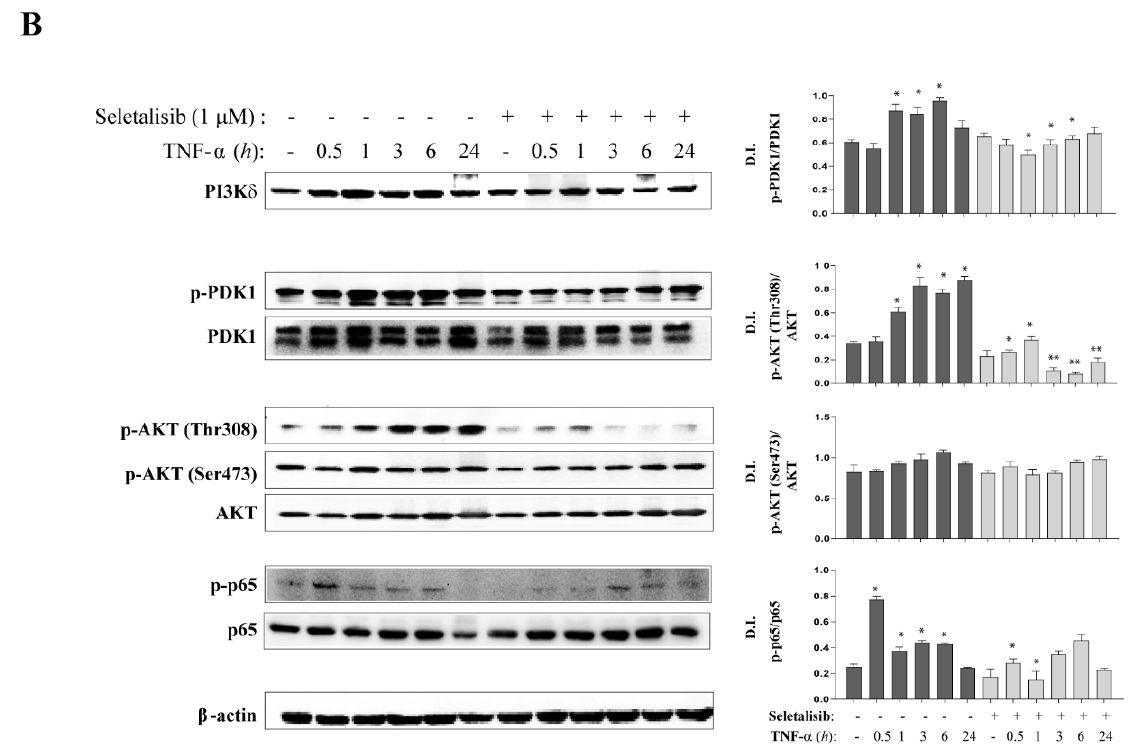
Figure 2. PI3K-dependent signaling pathways induced by IL-22 and TNF- α are down-regulated by selective PI3K δ inhibition. ( A , B ) Protein extracts were obtained from psoriatic keratinocytes stimulated or not with IL-22 ( A ) or TNF- α ( B ) in presence or absence of seletalisib (1 µ M) for the indicated time points and subjected to WB analysis to detect the expression of PI3K δ the phosphorylation of PDK1 (S241) and AKT (Thr308, Ser473), as well as the phosphorylation of S6 in ( A ) and of p65 in ( B ). Filters were re-probed with anti-PDK1, -AKT ( A , B ), -S6 ( A ), and -p65 ( B ). β -actin levels were detected as a loading control. One representative experiment out of three performed is shown. ( A , B ) Graphs show mean of D.I. ± SD of bands obtained from WB analysis of protein extracts obtained from psoriatic keratinocytes ( n = 3 strains). Data are expressed as mean ± SD of each D.I. value of total protein levels or the ratio of phosphorylated/unphosphorylated proteins normalized to β -actin expression. Results were obtained by three independent experiments. * p ≤ 0.05, ** p ≤ 0.01 were assessed by paired Student’s t test comparing resting with cytokine-treated cells, or seletalisib-treated with untreated